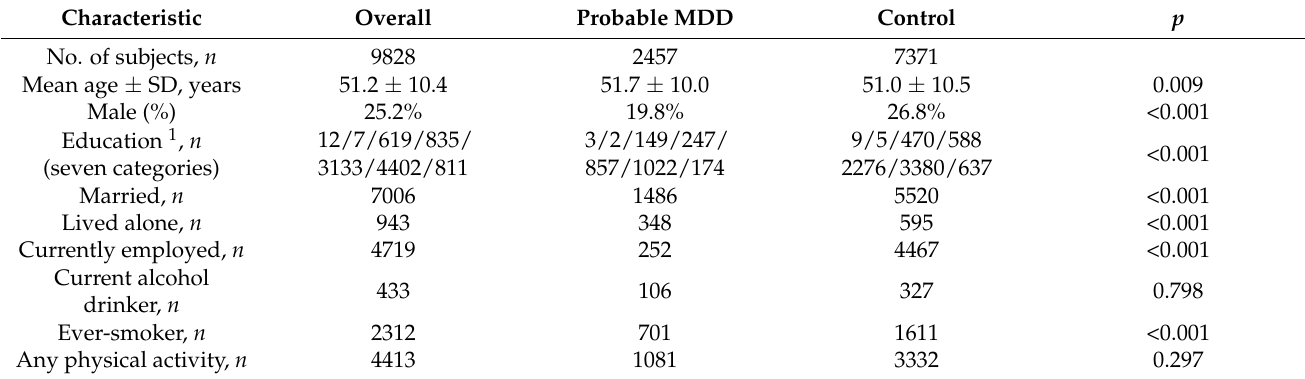
Table 1. Demographic and clinical characteristics of study subjects.